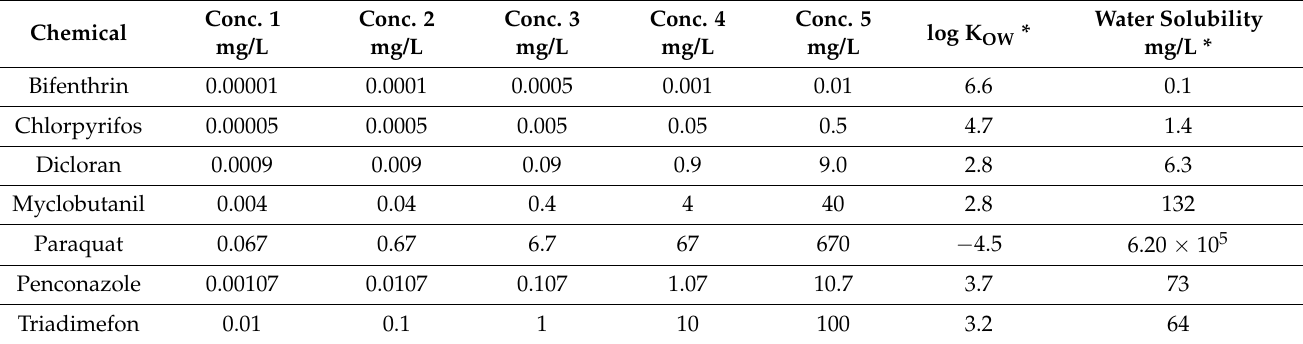
Table 1. Chemicals and concentrations used to conduct range finding and determine the LC 50 and LC 10 values at 5 PSU and 15 PSU (*